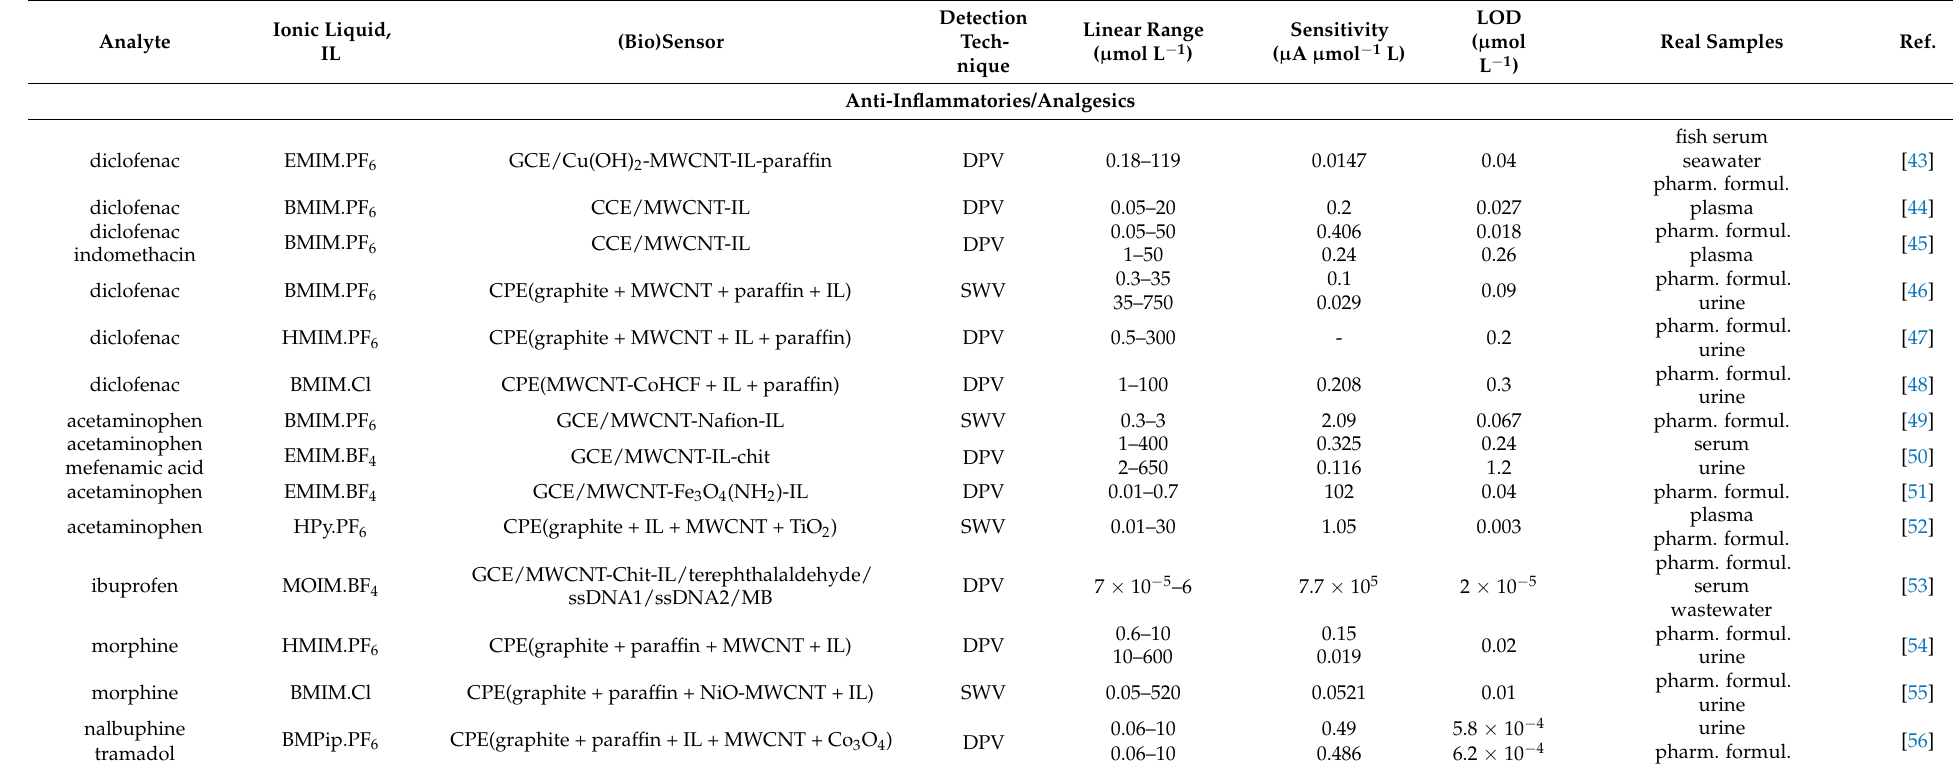
Table 1. Electrochemical sensors based on MWCNT-IL nanocomposites for pharmaceutical